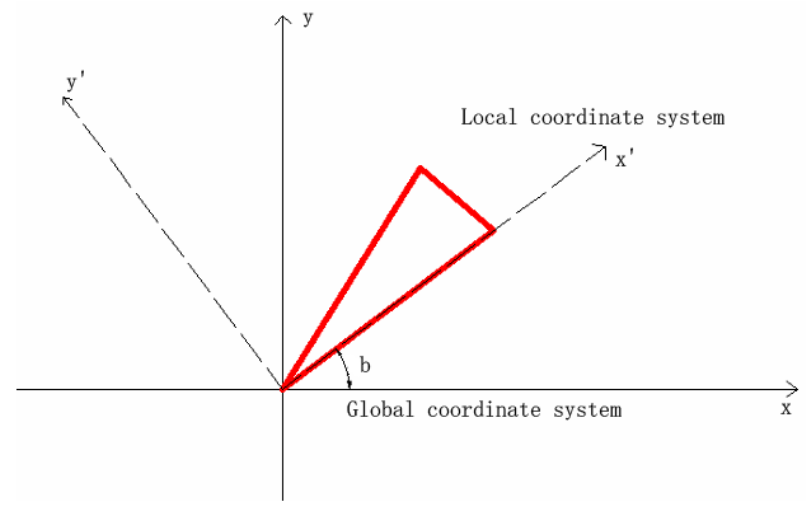
Figure 4. Conversions between local and global coordinate systems.